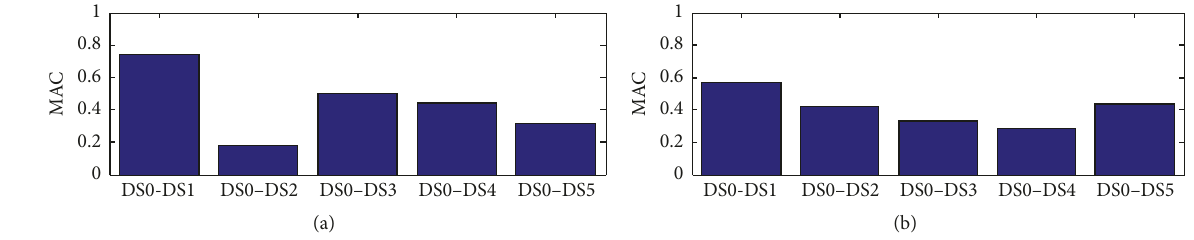
Figure 12: Average MAC experimentally determined. (a) SSI method and (b) FDD